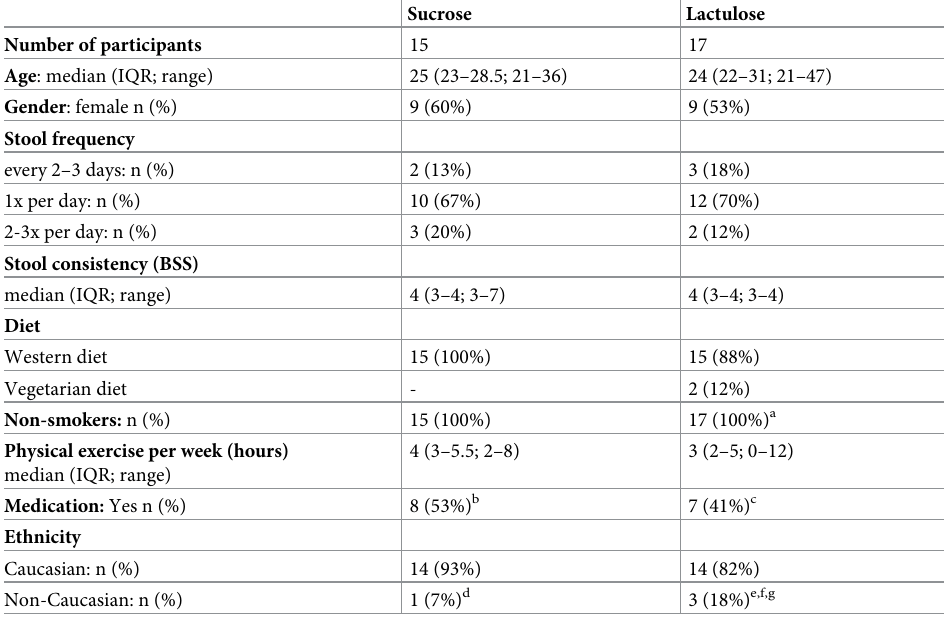
Table 1. Epidemiological and clinical characteristics of the study population. BSS: Bristol stool scale; IQR: inter- quartile range.